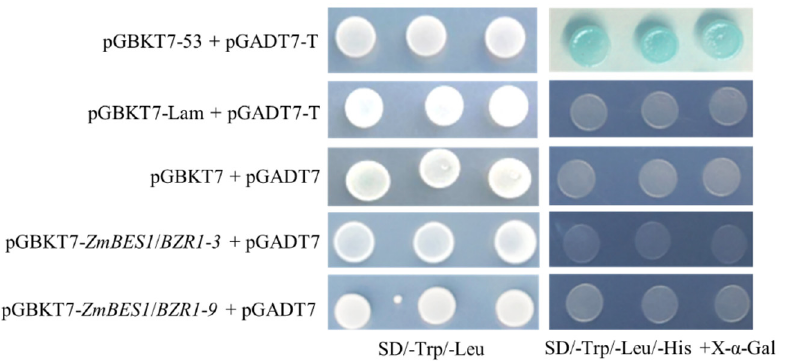
Figure 3. The transcriptional activation assay. The pGBKT7- ZmBES1/BZR1-3 with pGADT7, and pGBKT7- ZmBES1/BZR1-9 with pGADT7, were co-transformed into yeast, respectively. The co-transformation of pGBKT7-53 with pGADT7-T was used as the positive control. The co- transformation pGBKT7-Lam with pGADT7-T and pGBKT7 with pGADT7 were used as the negative control.